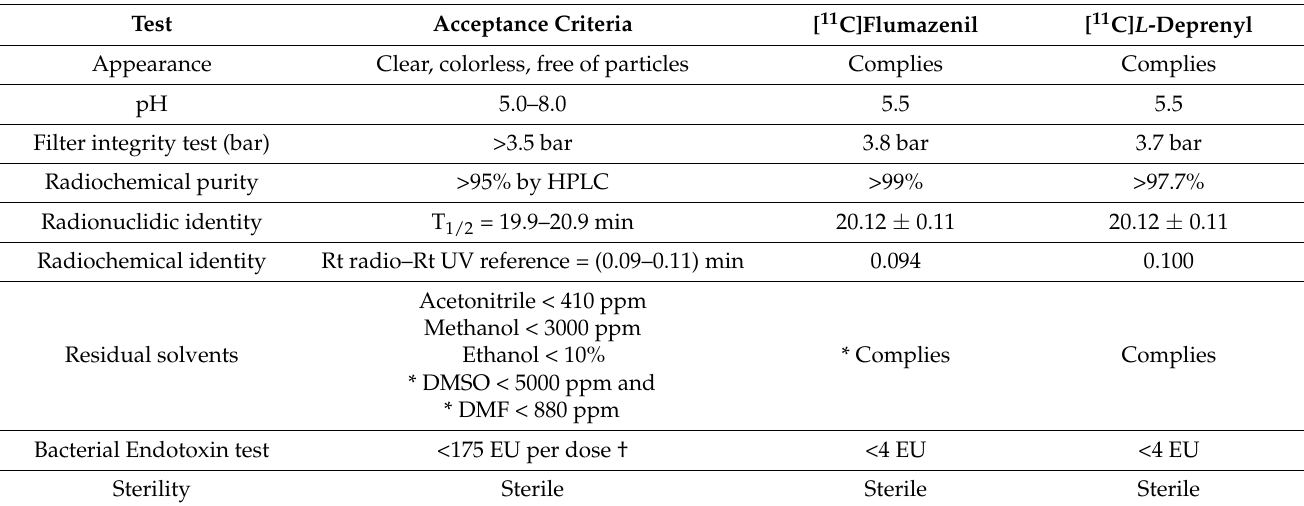
Table 2. Summary of quality control tests for [ 11 C]flumazenil and [ 11 C] L